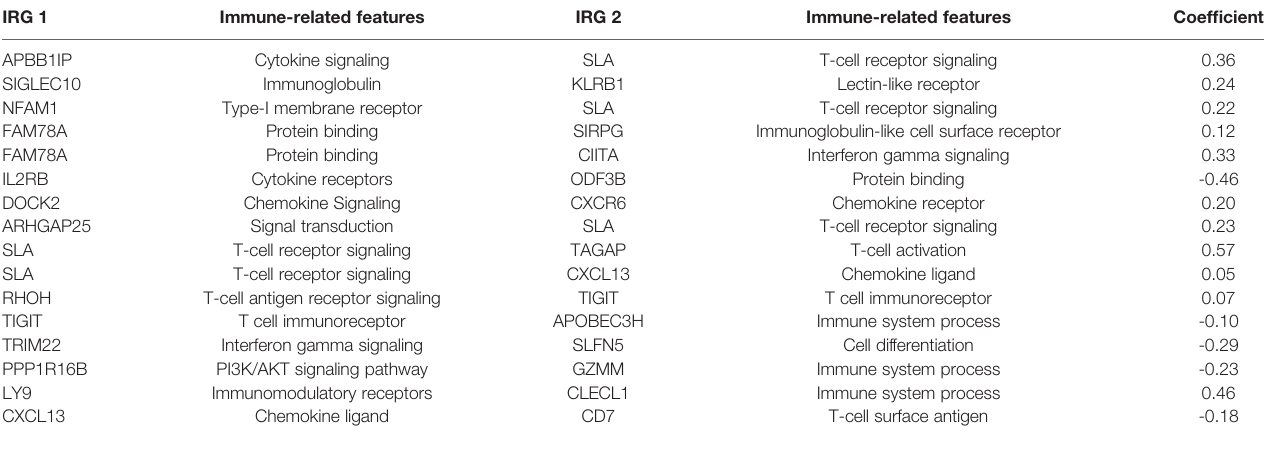
TABLE 1 | Prognostic risk scoring model (PRSM) information including 16 immune-related gene pairs (IRGPs). IRG 1 Immune-related